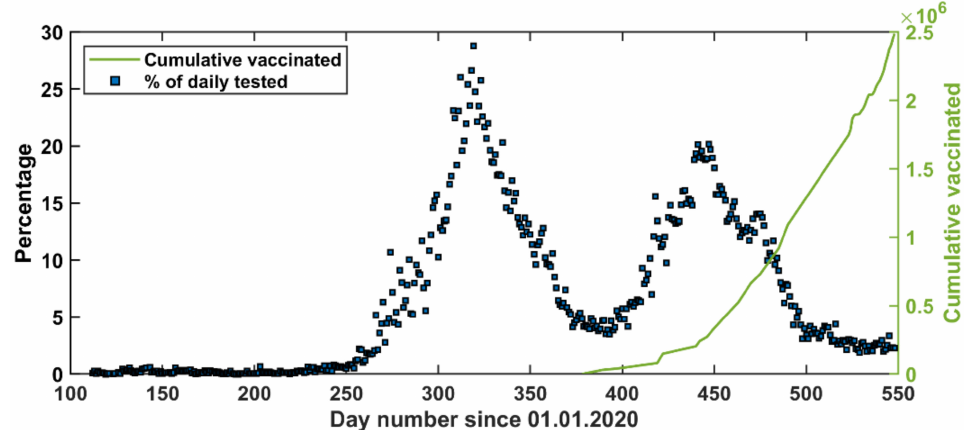
Figure 4. Daily percentage of the positive qPCR cases out of the performed tests and cumulative vaccination (at least